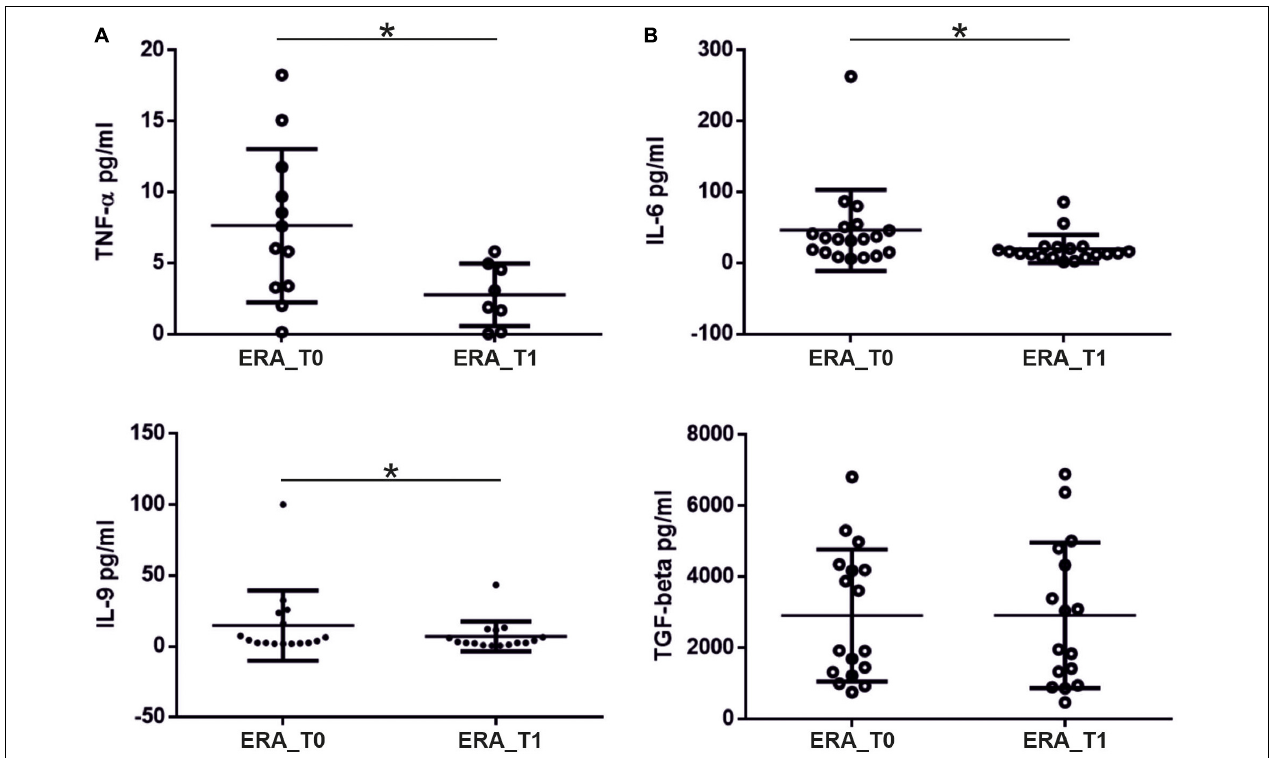
FIGURE 4 | Levels (pg/ml) of pro-inflammatory cytokines measured in the serum of patients with RA at T0 and T1. (A) Significant reduction in serum TNF- α levels and (B) IL-6 levels at T1 compared to T0 in patients with rheumatoid arthritis. * significant difference at alpha value